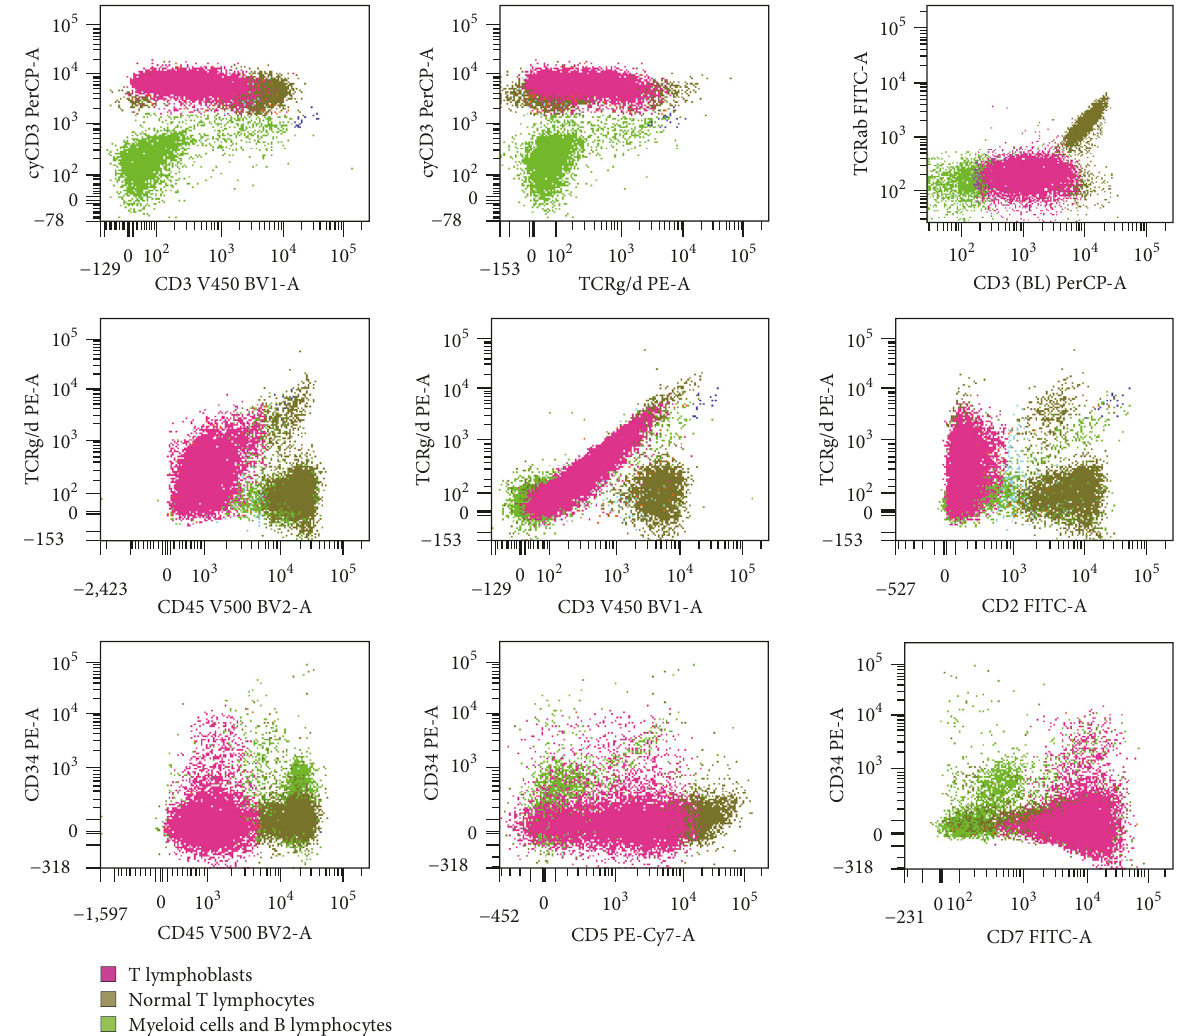
Figure 6: Representative flow cytometric histograms of bone marrow aspirate from patient